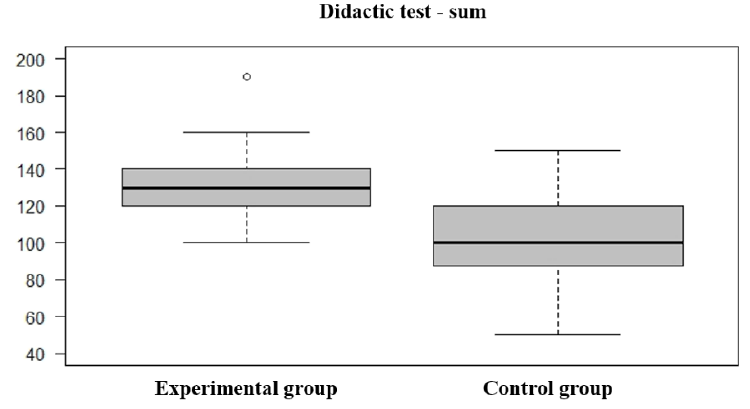
Figure 2. Hypothesis 1 – Didactic test